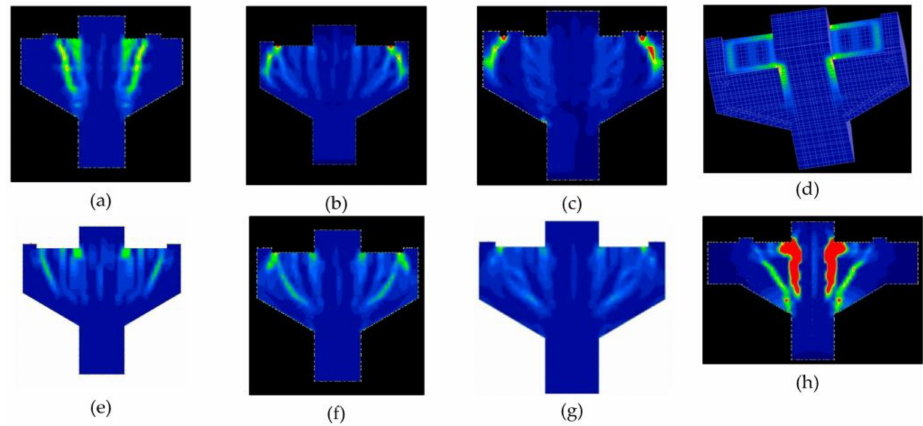
Figure 12. Principle strain contours in the simulation: ( a ) D-C; ( b ) PE-C; ( c ) ResCap-PE-C; ( d ) CFRP-CF-2L; ( e ) CFRP-CF-2L(A); ( f ) CFRP-FW-1L; ( g ) CFRP-FW-2L; and ( h )